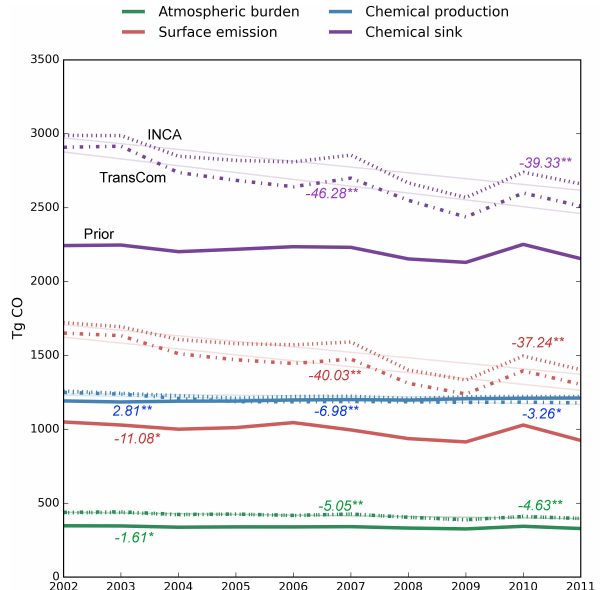
Figure 8. Time series of global mean annual CO budget changes from 2002 to 2011. Solid lines indicate the prior values (mean val- ues of the two OH fields are shown for the prior chemical CO pro- duction and sink). Dash-dot lines indicate posterior with TransCom OH and dotted lines represent posterior with INCA-OH. Beside each line, the linear slopes are denoted if the trend is statistically significant, ∗ denotes the 95% confidence level and ∗∗ denotes the 99% confidence level.